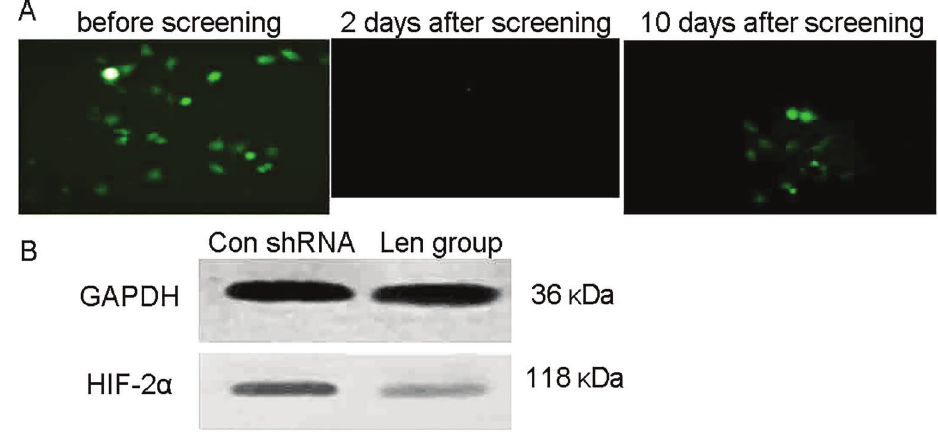
Figure 1. Ef fi ciency assessment of lentiviral vector transfecting in rat glomerular endothelial cells (rGENCs). A, Screening of monoclonal cells by puromycin amino nucleoside. The distinct colonies were formed at 10 days after screening by puromycin ( fl uorescence microscopy (cid:3) 200). B, Expression of HIF-2 a was detected by western blot to evaluate the ef fi ciency of lentiviral vector transfecting in rGENCs. Con shRNA: negative control group; Len group: HIF-2 a lentivirus transfected group; GAPDH: glyceraldehyde-3phosphate